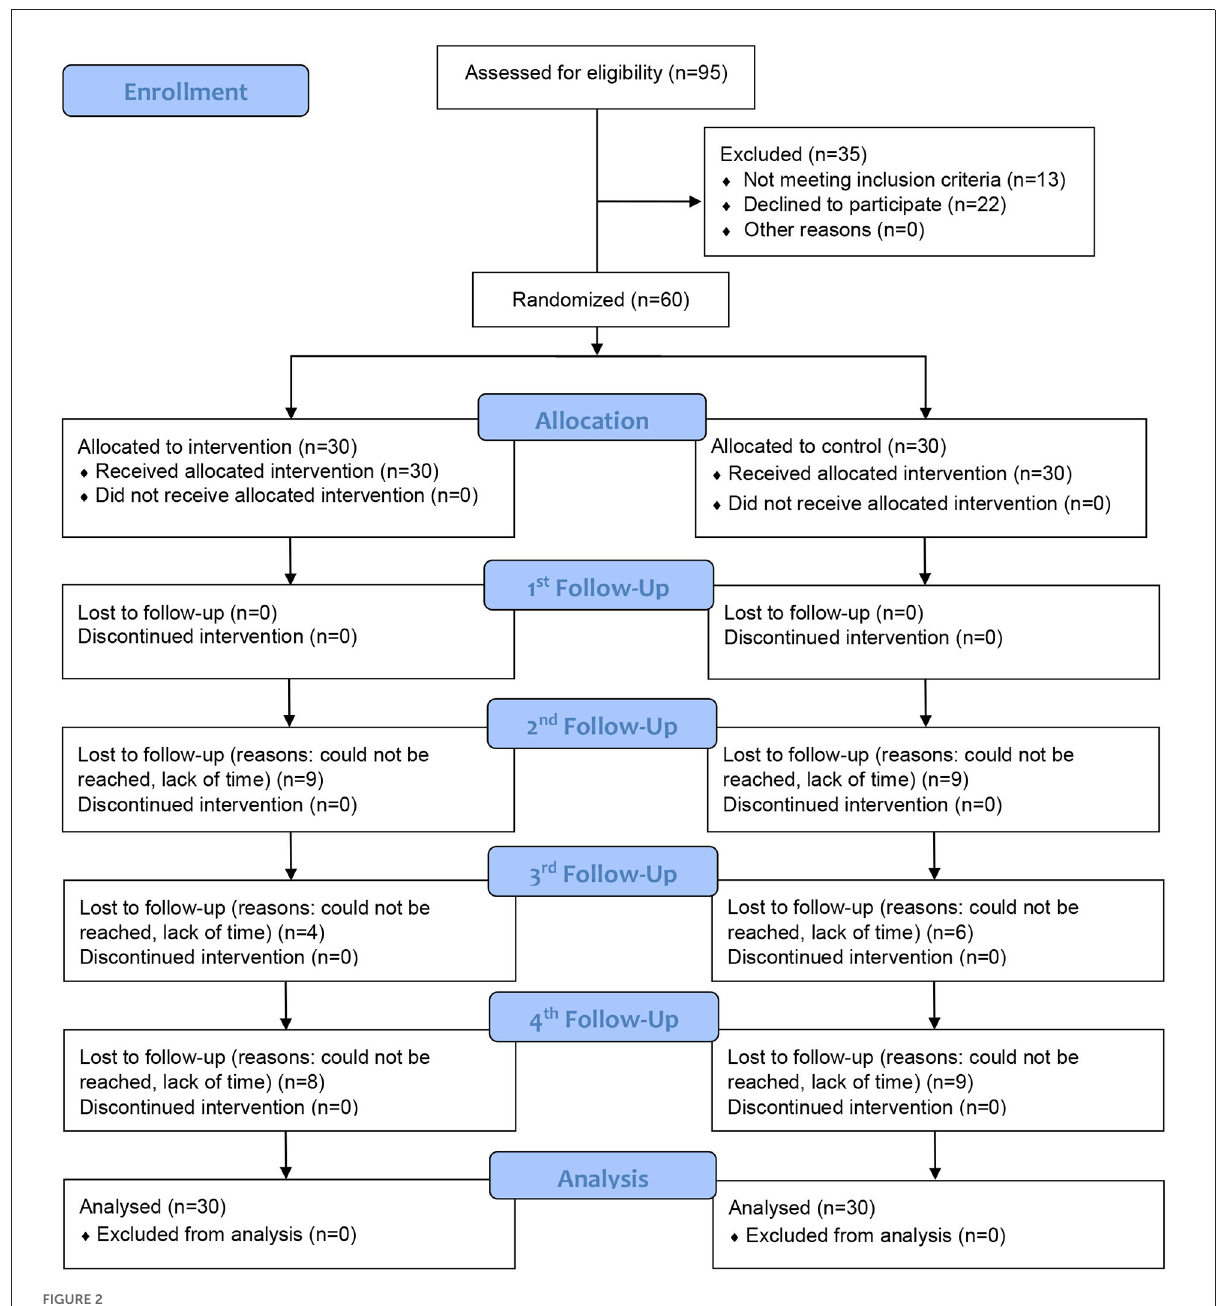
FIGURE2 CONSORT